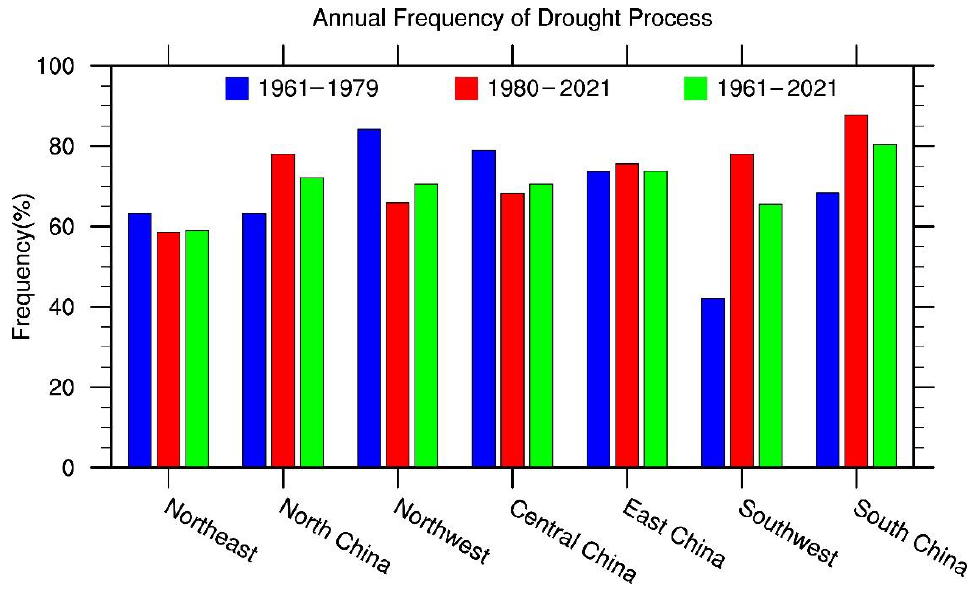
Figure 4. Annual Frequency of Drought Process in Different Periods in Seven Regions of China.